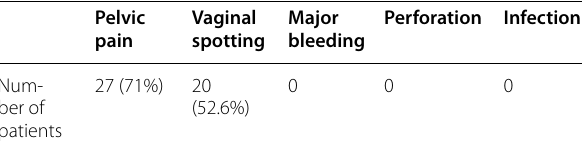
Table 3 Complications of transcervical fallopian tube recanalization Pelvic